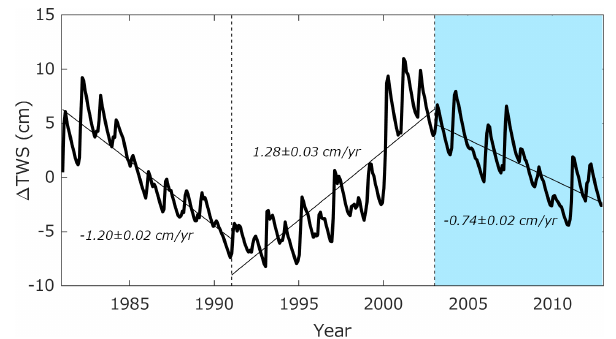
Figure 9. The TWS estimates of the Sandy Desert basin obtained from CABLE 0.05 ◦ between January 1981 and December 2012. The long-term trend estimates (centimeters per year) in different periods are given. The blue highlight indicates the GRACE period (January 2003–December